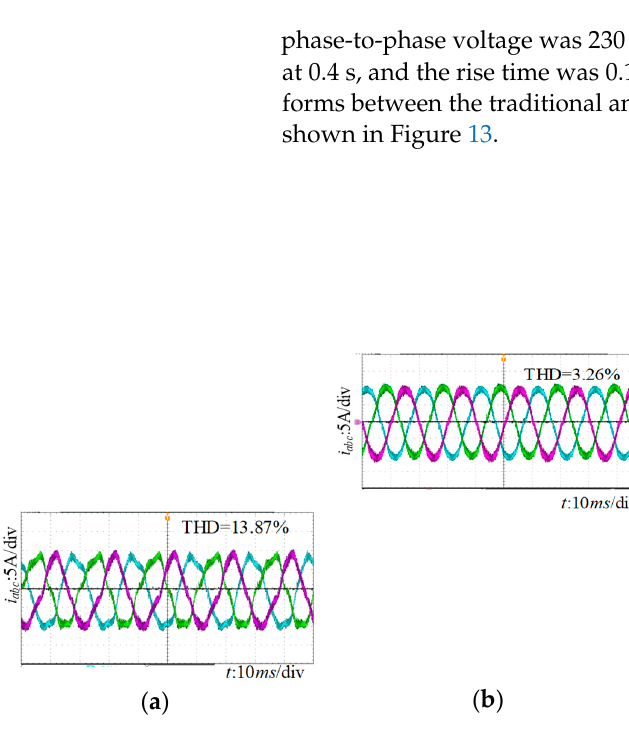
Figure 13. Experimental results of grid current comparison. ( a ) current responses of the traditional control method when frequency changes. ( b ) current responses of the proposed method when frequency changes. ( c )current responses waveform.